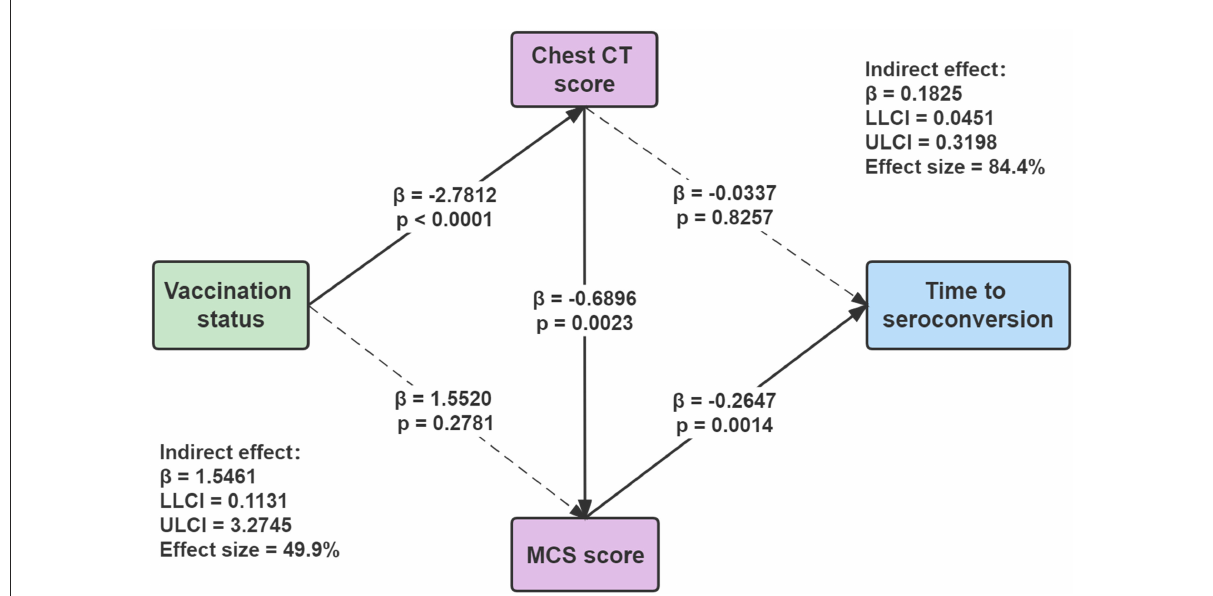
FIGURE3 Mediation analyses for the association among vaccination status, chest CT score, MCS score, and time to seroconversion. Standardized β -coefficient was derived from mediation models controlling for age, sex, and education. Values are standardized path coefficients with 95% CIs in parentheses. The effect size of mediation was estimated from the proportion of indirect effect in the total effect. MCS, mental component summary. ULCI, upper limit of the 95% confidence interval; LLCI, lower limit of the 95% confidence